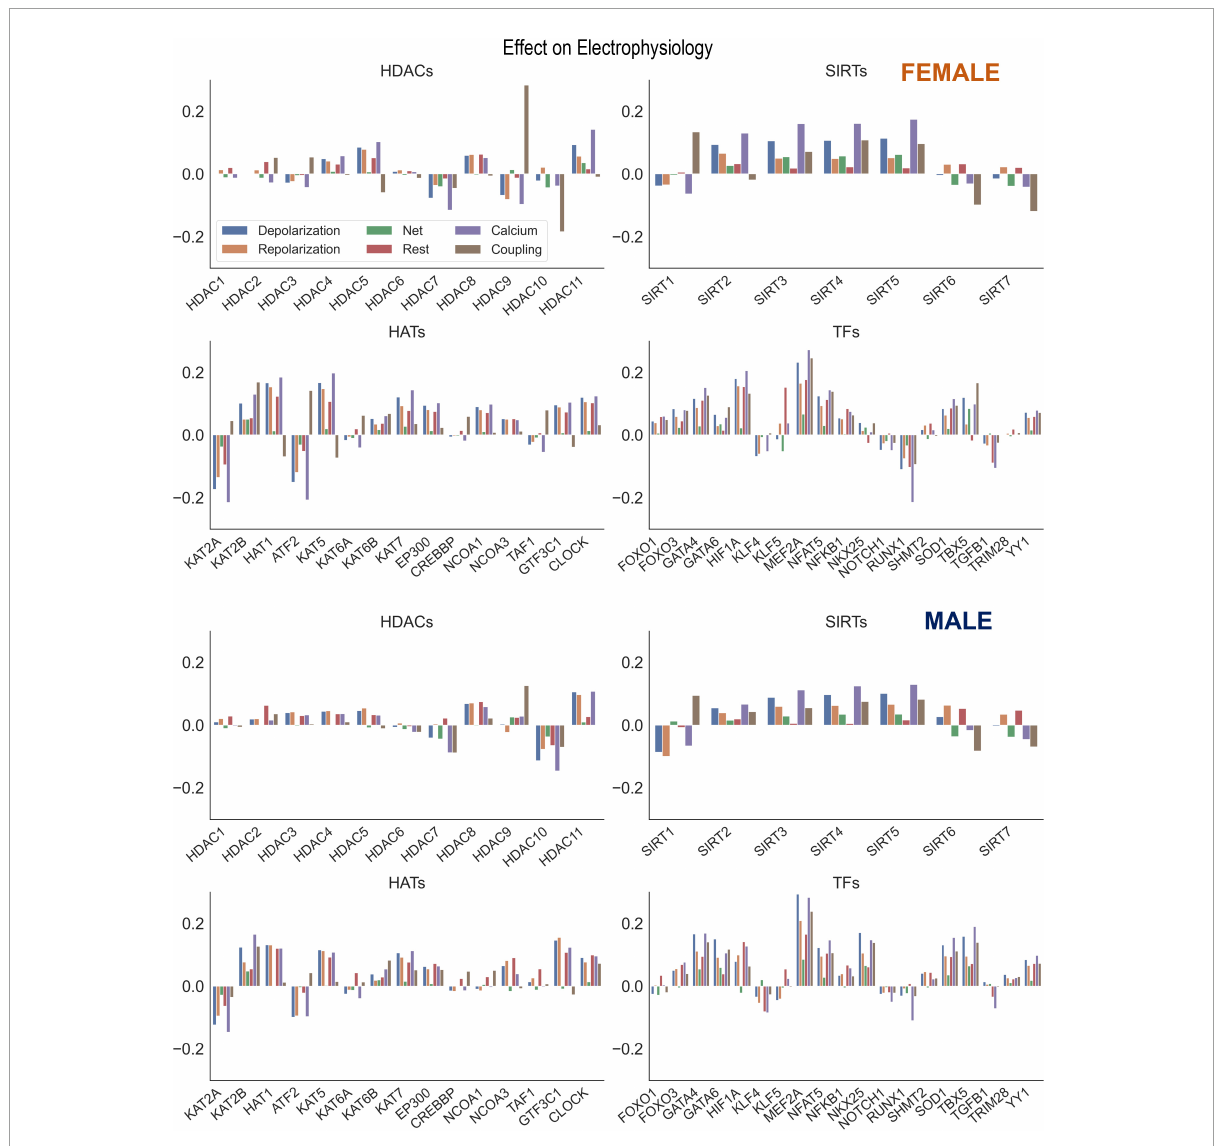
FIGURE6 Control of key genes defining cardiac electrophysiology by HDACs, SIRTs, HATs, and TFs. Using the results from the PLS beta matrix, the effects of the HDACs, SIRTs, HATs, and TFs were summed to quantify the effect on the electrophysiology of cardiomyocytes. The 6 groupings examined were Depolarization (SCN5A, CACNA1C, SLC8A1), Repolarization (KCNH2, KCNQ1, KCNJ2, ATP1A1), Net (Depolarization—Repolarization), Resting (KCNJ2, ATP1A1), Calcium Handling (ATP2A2, RYR2, SLC8A1, CACNA1C), and Coupling (GJA1). This analysis was done for both female (top) and male (bottom) samples